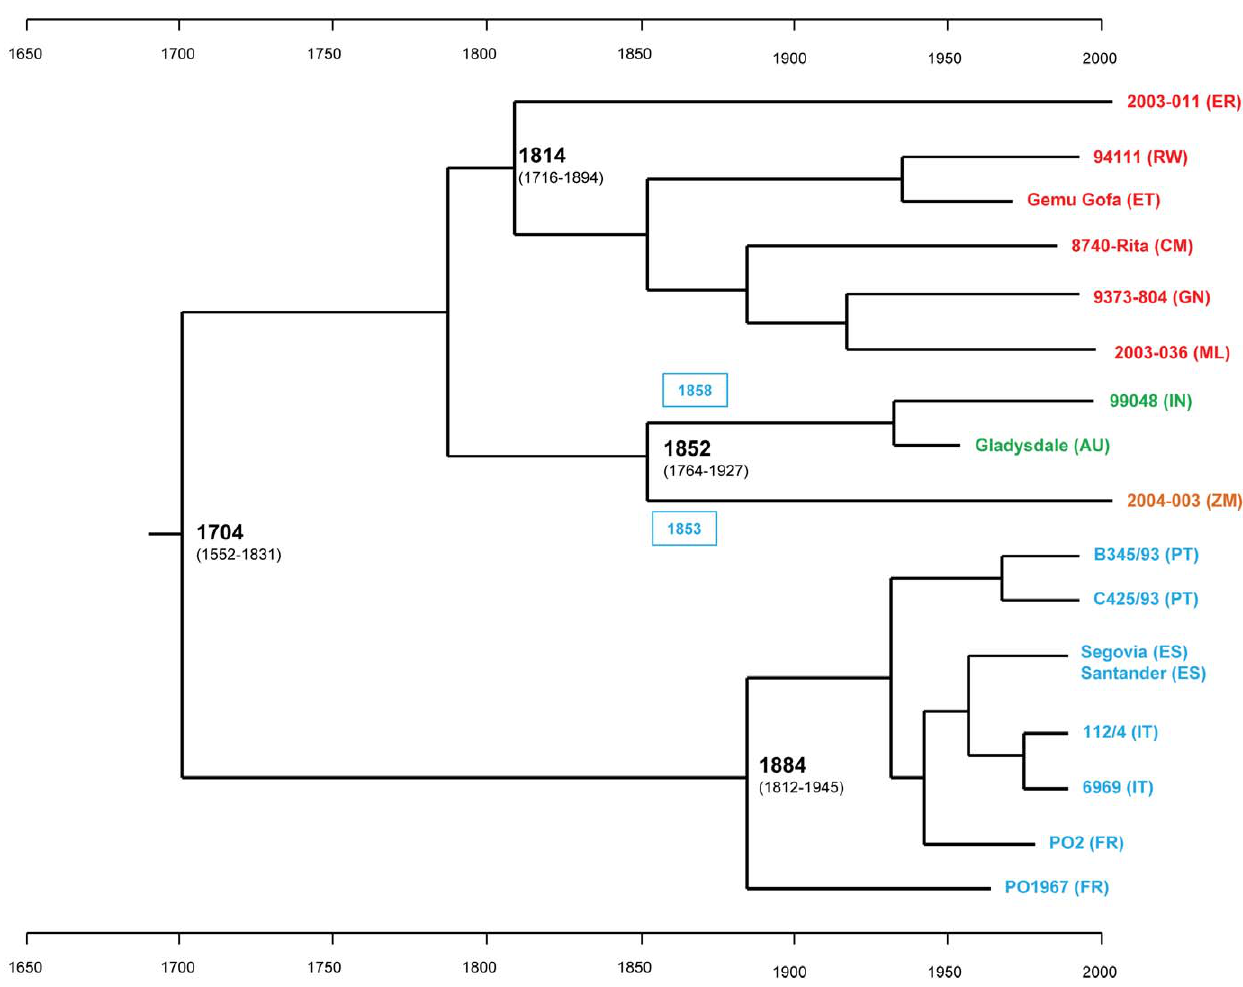
Figure 3. Bayesian inference of Mycoplasmamycoides subsp. mycoides ‘‘Small Colony’’ evolutionary history. The maximum credibility tree resulted from BEAST analysis with the concatenated sequence of 62 core genes and using a strict molecular clock and a GTR + I substitution model. Branches are scaled by time according to the scales displayed at the bottom and top of the figure. Strain names are colored according to the sampling location (see Figure 1). Country codes are indicated in brackets (for abbreviations refer to Figure 2). The dates at the nodes refer to the most recent common ancestor (MRCA) estimated by BEAST for all strains deriving from these nodes. The 95% Highest Posterior Densities (HPD) values are displayed in brackets. The node leading to the Australasian and South African strains was used as a control of estimation accuracy. The model dates their MRCA around 1850. This agrees with the dates of CBPP introduction in Australia (1858) and Southern Africa (1853), indicated in blue boxes. According to this model, the MRCA for all the tested strains emerged around 1700 and the MRCA for all the Sub-Saharan strains around